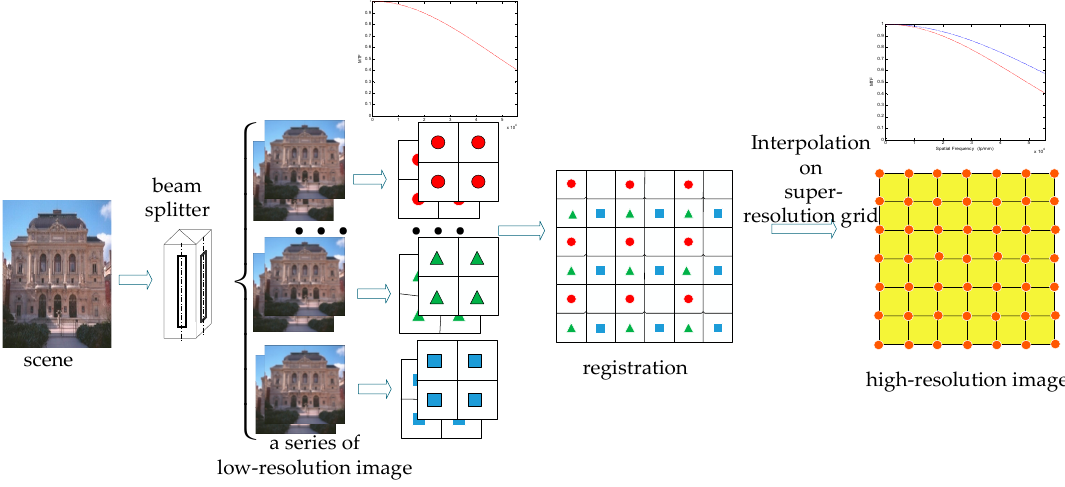
Figure 1. Schematic of super-resolution technique.